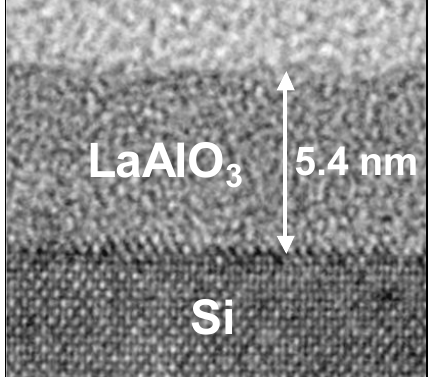
Figure 12. Cross-sectional TEM image of the as-deposited